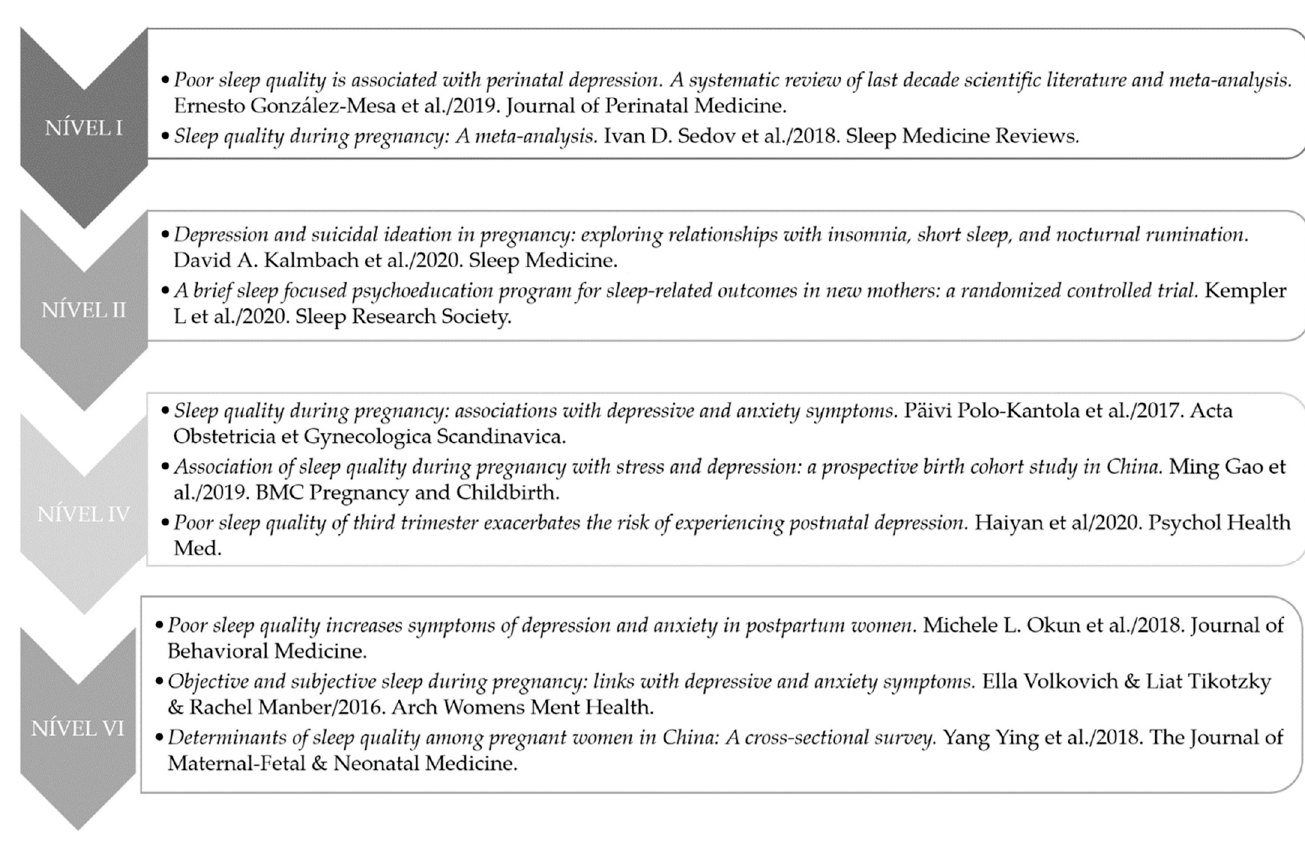
Figure 2. Included studies according to the hierarchical level of scientific evidence [11–20].